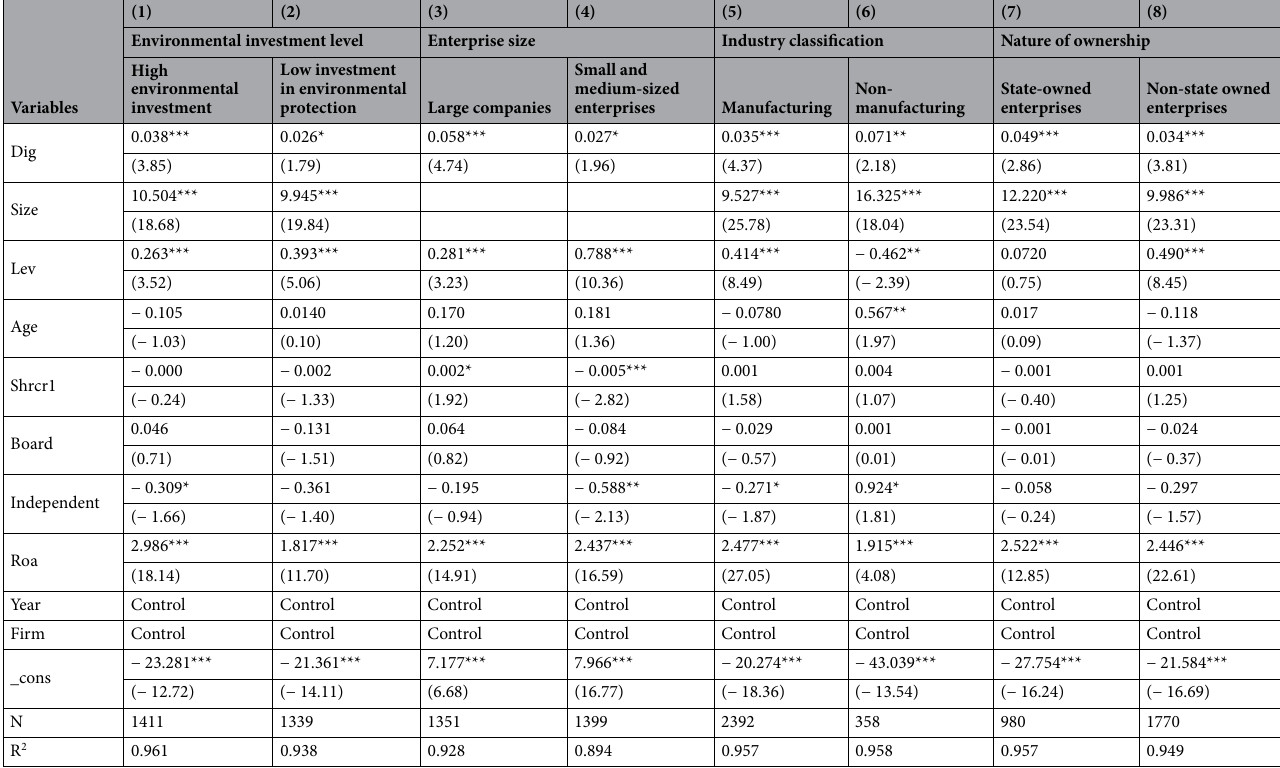
Table 8. Regression results of firm heterogeneity. T-statistics are shown in parentheses. ***, ** and * indicate 1%, 5% and 10%